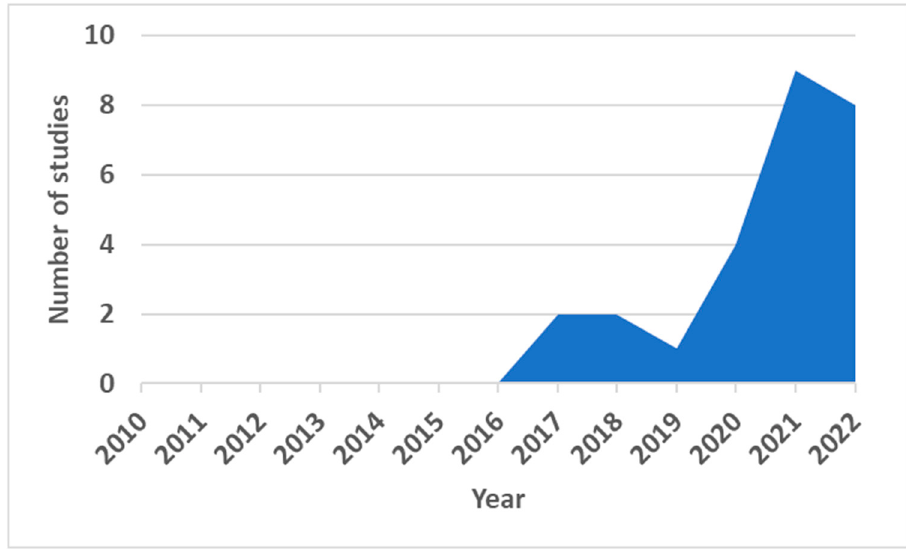
Figure 4. ML employment in the prediction of functional outcomes in rehabilitation in post-stroke survivors.